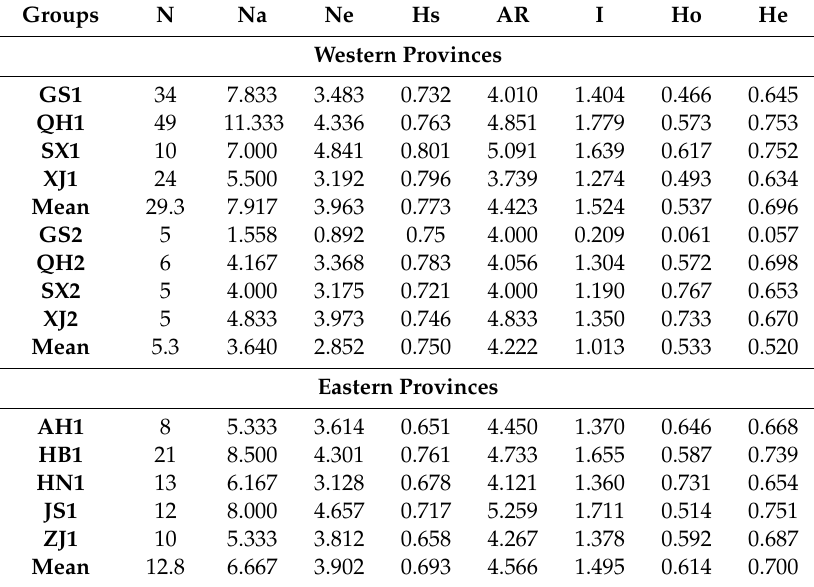
Table 2. Genetic diversity indices of two Sitobion avenae biotypes from nine